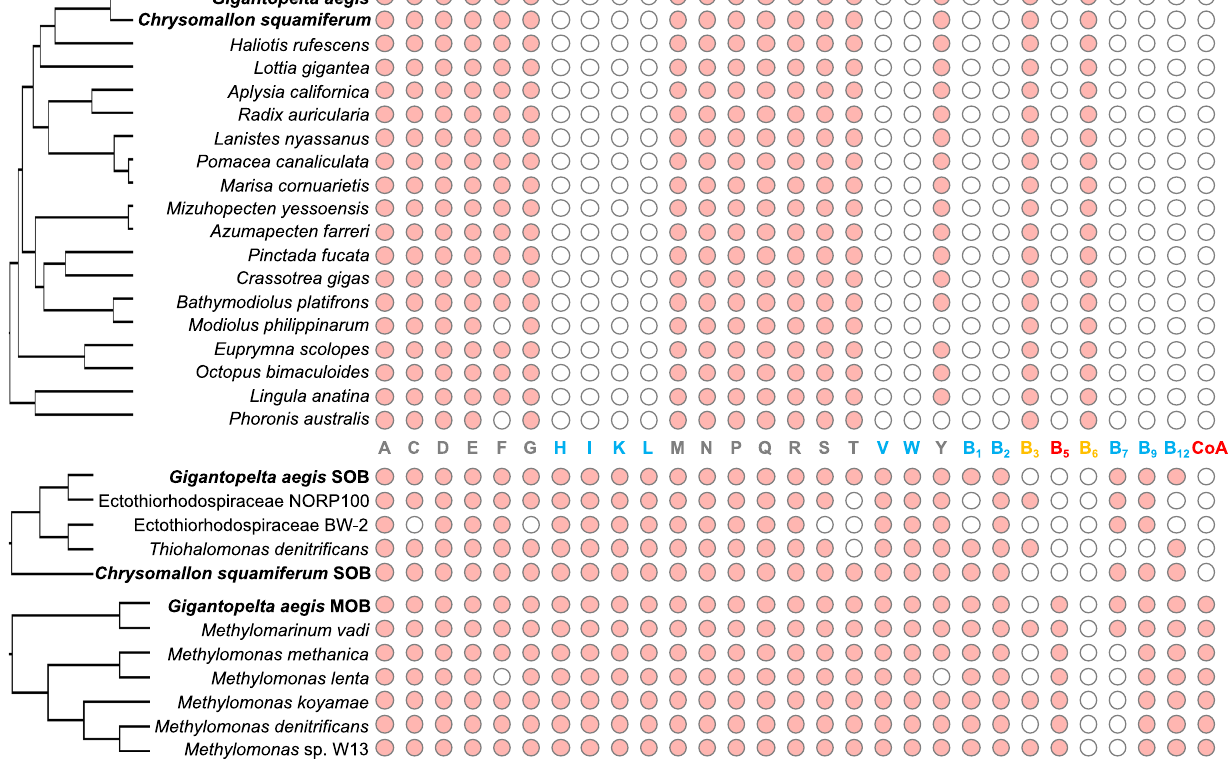
Fig. 5 Biosynthesis capabilities of nutrients in Gigantopelta aegis holobiont and its relatives. Presence (pink circle) and absence (white circle) of biosynthesis capabilities of 20 amino acids, 8 vitamins and coenzyme A in Gigantopelta aegis and 18 other molluscan taxa, as well as G. aegis symbionts and their free-living relatives. A: alanine, C: cysteine, D: aspartate, E: glutamate, F: phenylalanine, G: glycine, H: histidine, I: isoleucine, K: lysine, L: leucine, M: methionine, N: asparagine, P: proline, Q: glutamine, R: arginine, S: serine, T: threonine, V: valine, W: tryptophan, Y: tyrosine, B 1 : vitamin B 1 , B 2 : vitamin B 2 , B 3 : vitamin B 3 , B 5 : vitamin B 5 , B 6 : vitamin B 6 , B 7 : vitamin B 7 , B 9 : vitamin B 9 , B 12 : vitamin B 12 , CoA: coenzyme A. The colour labelling scheme of nutrients: blue (H, I, K, L, V, W,